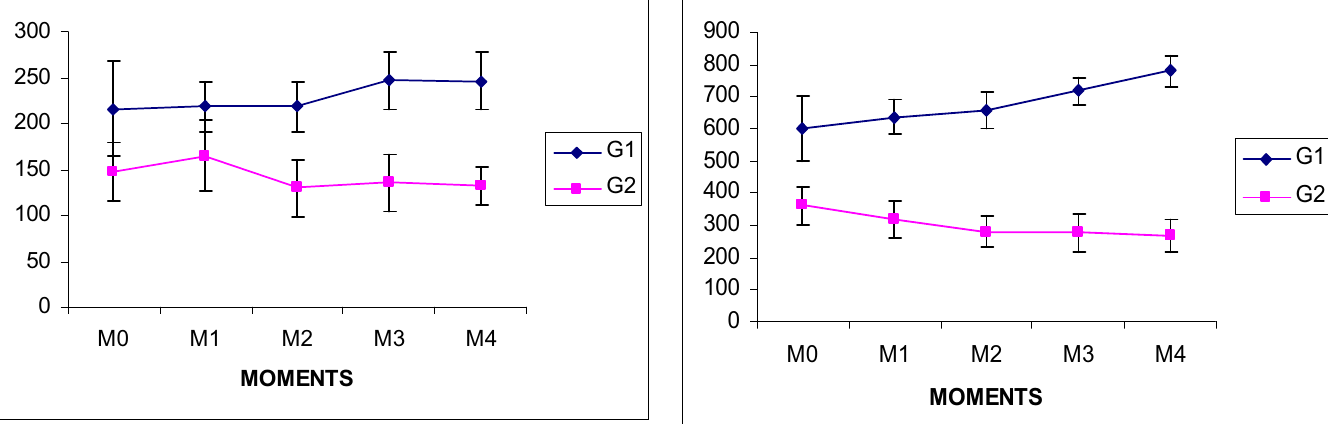
FIGURE 5 - Mean values for protein concentration (mg/100 mg of tissue) of samples for the ileal segment in the two groups at the experimental moments